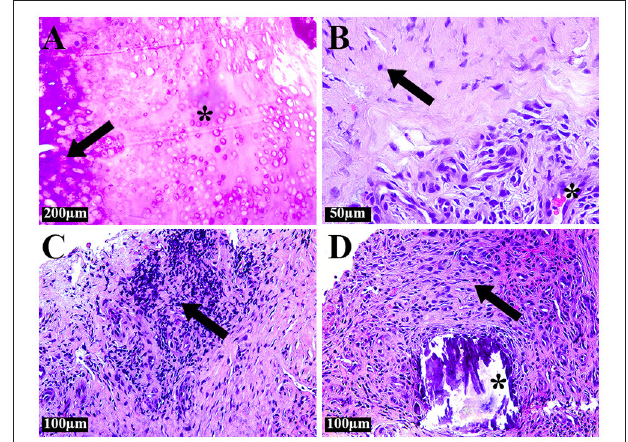
FIGURE 2 | Histological examination of excised tissues. (A) Large area of embryonic cartilage (*). Small chondrocytes without lacunae, dystrophic changes in some cells, uneven distribution of chondrocytes, an increased amount of extracellular matrix. Small area of mature cartilage (arrow). (B) Fibrous connective tissue (arrow). Granulation tissue with numerous blood vessels (*). (C) Fibrous tissue infiltrated with immune cells (arrow). (D) Fragment of mineral deposition (*) surrounded by tissue infiltrated with leukocytes and macrophages